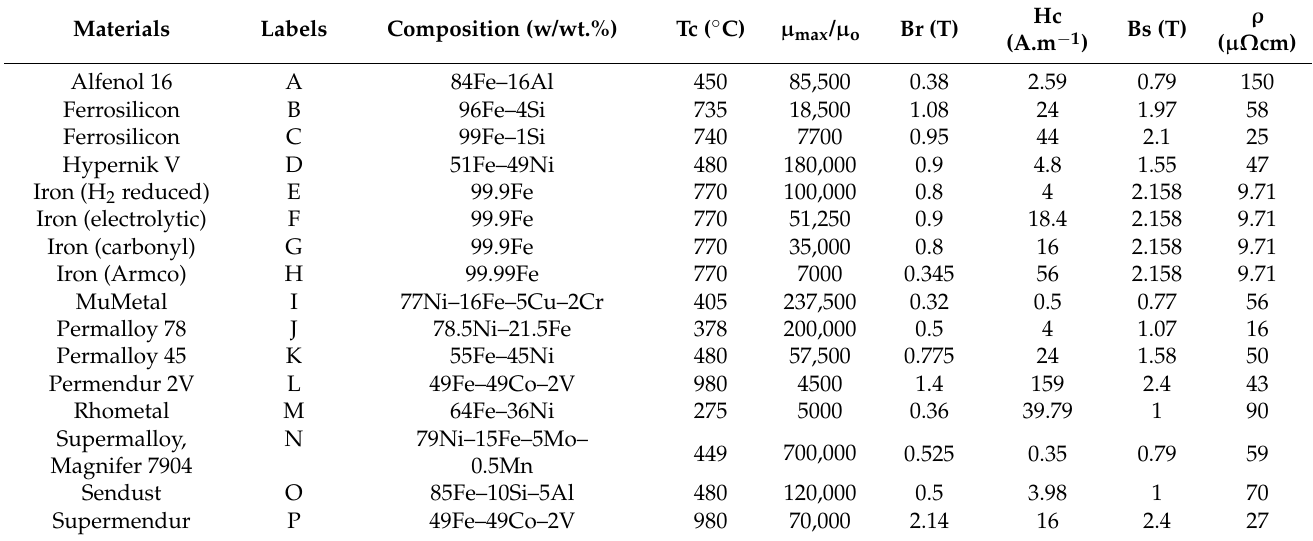
Table 1. List of soft magnetic materials with their physical properties